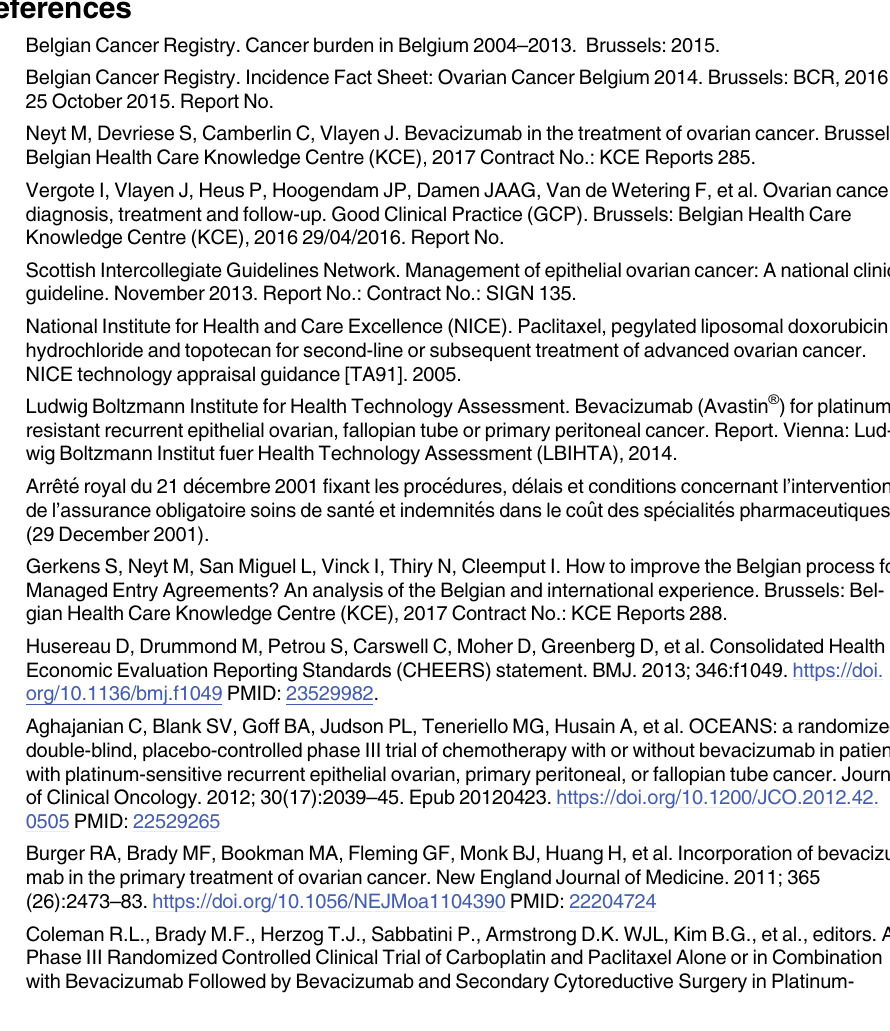
S2 Fig. Figures with results for other modelled